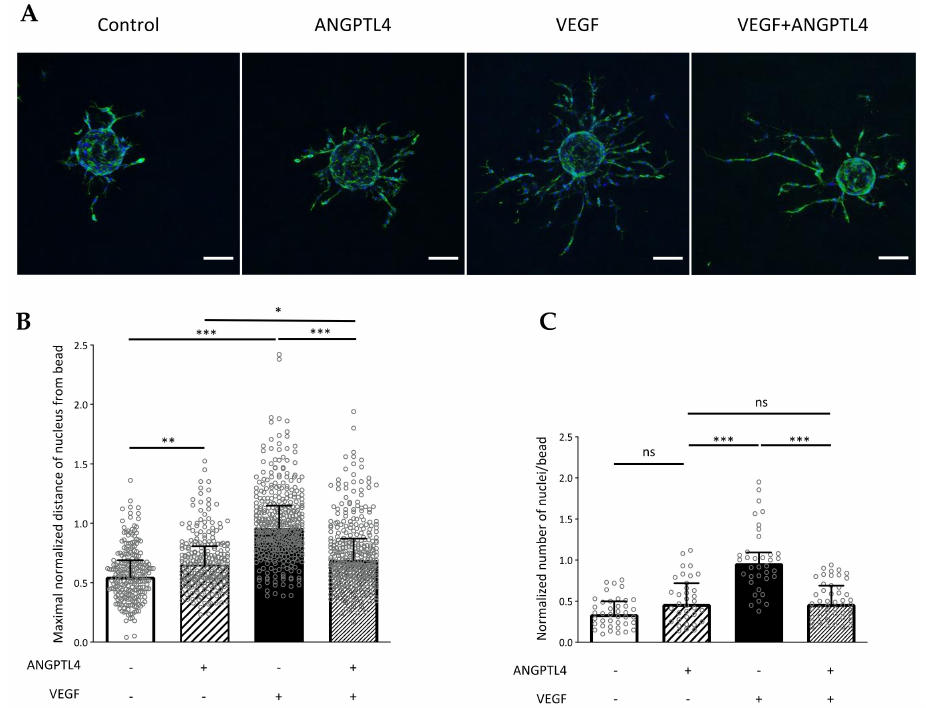
Figure 5. Regulation of 3D endothelial cell migration by ANGPTL4 and VEGF. ( A ) Cell responses were assessed by incubating endothelial cells seeded on beads with endothelial growth medium without or with ANGPTL4 (2.5 µ g/mL) and/or VEGF (2.5 ng/mL) for 48 h. Cells were fixed and labelled for F- actin (green) and nuclei (blue). Scale bar: 100 µ m. ( B ) Median values of normalized maximal distance covered by cell (nucleus) from the bead for each condition (+interquartile). ( C ) Median values of normalized number of nuclei emerging from a bead (+interquartile). Nuclei closely surrounding the bead are not considered. Individual values are normalized to the mean value of VEGF condition for each experiment. Values were measured in three independent experiments. ns: p > 0.05, * p ≤ 0.05, ** p ≤ 0.01, *** p ≤ 0.001